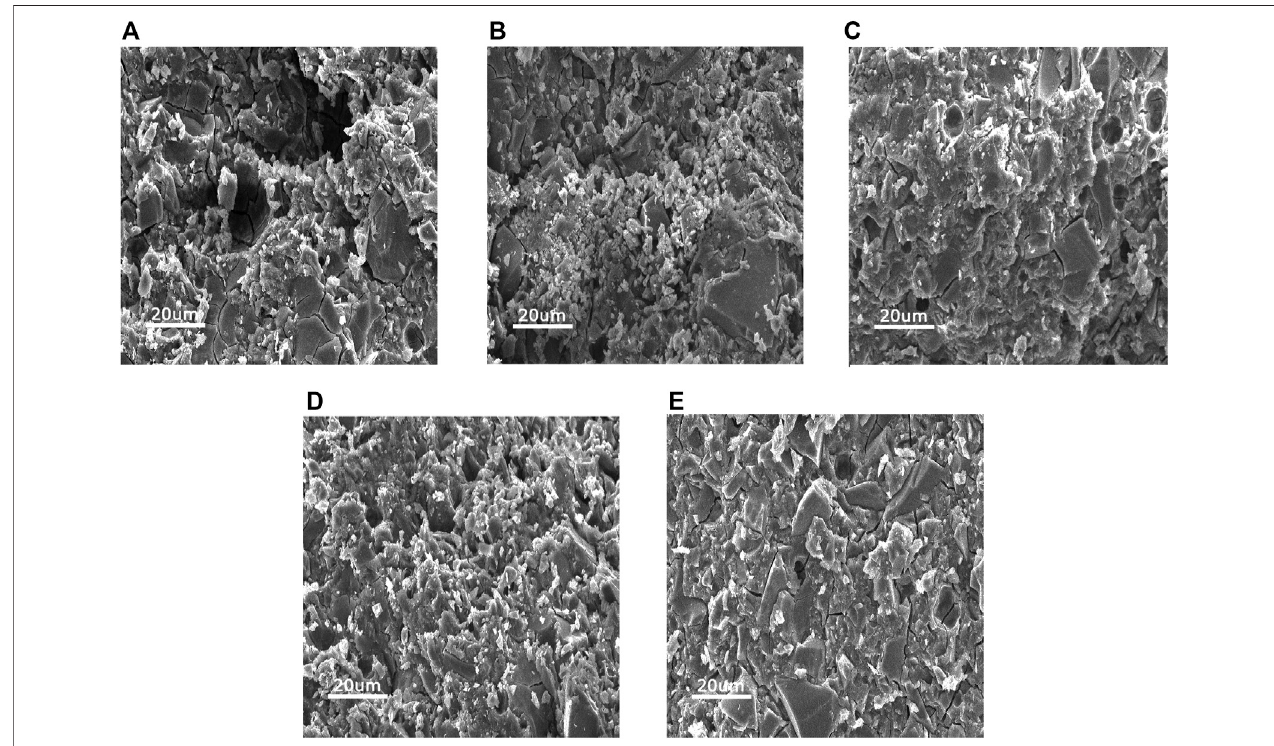
FIGURE 5 | The SEM images of the fractured surfaces of h-BN-TiO 2 /GIC composites after the compression test with h-BN-TiO 2 nanocomposite concentration of (A) 0 wt%, (B) 0.3 wt%, (C) 0.7 wt%, (D) 1.1 wt%, (E) 1.5 wt%.